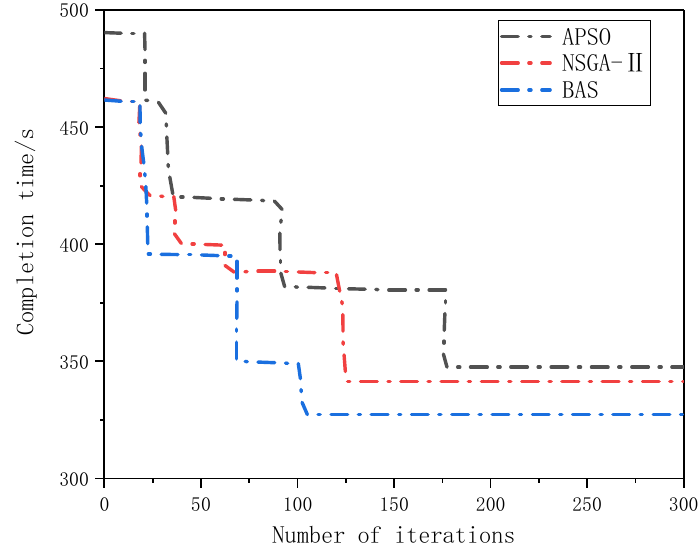
Figure 5. Iteration diagram of station waiting time.